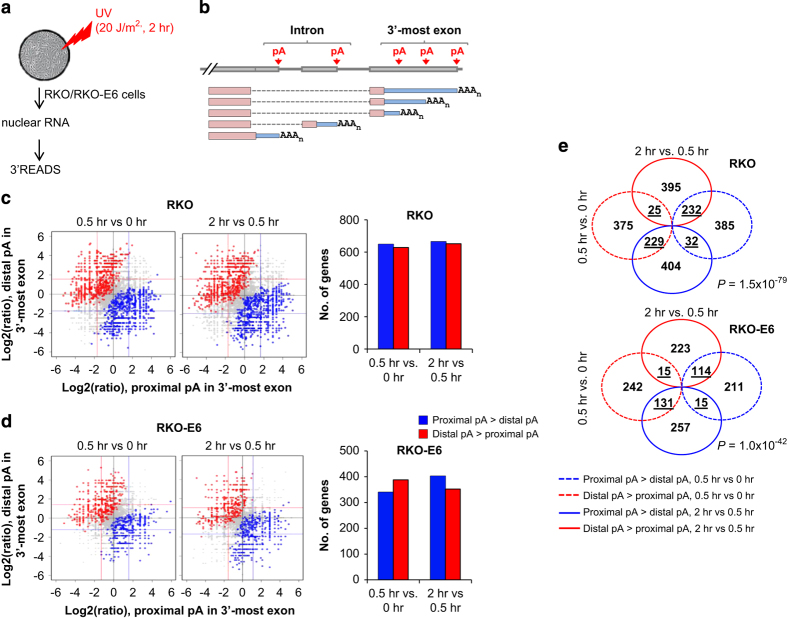
Regulation of 3ʹUTR-APA in both RKO and RKO-E6 cells after UV treatment. (a) Experimental design for analysis of APA in UV-treated cells using 3ʹREADS. (b) Schematic showing two types of APA examined in this study, namely intron-APA and 3ʹUTR-APA. (c, d) Comparison of 3ʹUTR-APA in RKO and RKO-E6 cells. Top 2 most abundant 3ʹUTR isoforms were chosen for each gene. Log2 ratios of expression are plotted between two isoforms. APA changes were examined in two time windows (0.5 vs 0 h, and 2 vs 0.5 h) and considered significant when P-value<0.05 (Fisher’s exact test). Blue dots represent genes with upregulated proximal pA isoform (3ʹUTR shortened), and red dots represents genes with upregulated distal pA isoform (3ʹUTR lengthened). Grey dots are genes that have no significant regulation. Colored lines indicate median values for blue or red dots. Number of genes with regulated 3ʹUTR is shown on the right plot. Blue and red dots on the left correspond to genes in blue and red bars, respectively. (e) Venn diagram comparing significantly regulated 3ʹUTR-pA isoforms for both RKO and RKO-E6 cells. P-value (Fisher’s exact test) indicates bias of distribution of the numbers in four overlapping areas (underlined). APA, alternative cleavage and polyadenylation; 3′READS, 3′ region extraction and deep sequencing; UTR, untranslated region; UV, ultraviolet.